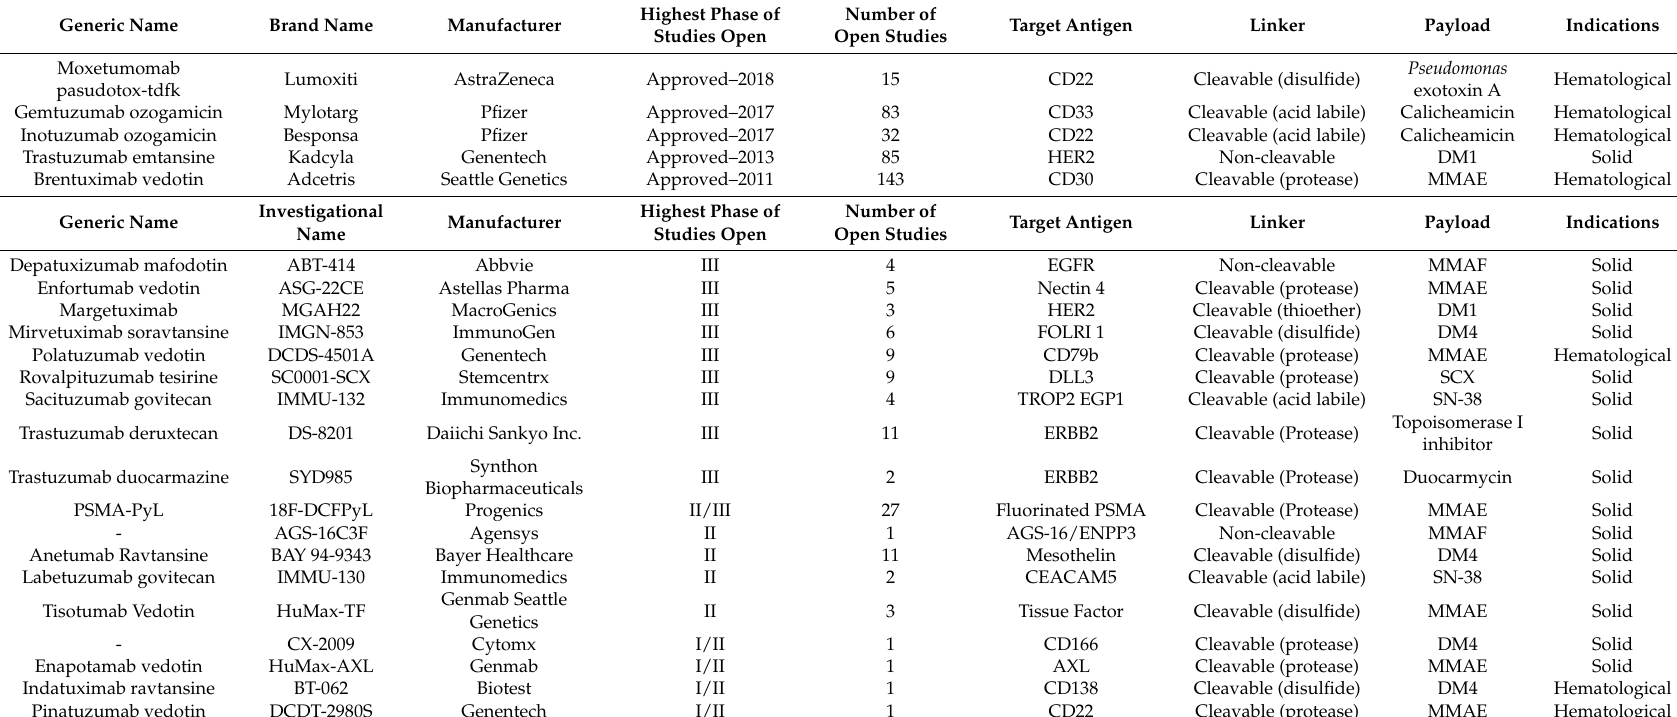
Table 1. Antibody–drug conjugates approved and under investigation (Phase II or